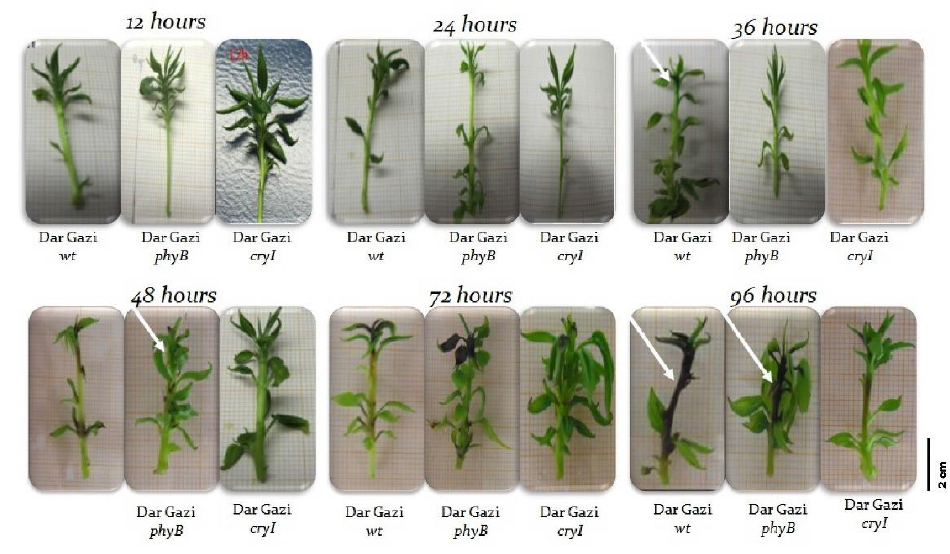
Figure 12. Sintomatology of bacterial infection. White arrows indicate the necrotic stem area. Gene expression analysis showed that transcript levels of PRs were more significant in photoreceptor over-expressing plantlets than in Dar Gazi-wt plantlets, indicating an increased capacity to counteract the infection (Figure 13). At the same time, the expression profile of erw genes indicated that only erw1 , coding for CAFS, was expressed during the first 12 h after the infection. In addition, erws transcript levels were also greater in plantlets over-expressing photoreceptors than in Dar Gazi-wt plantlets, suggesting a dynamic interaction occurring during the bacterial invasion of host tissues (Figure 13).